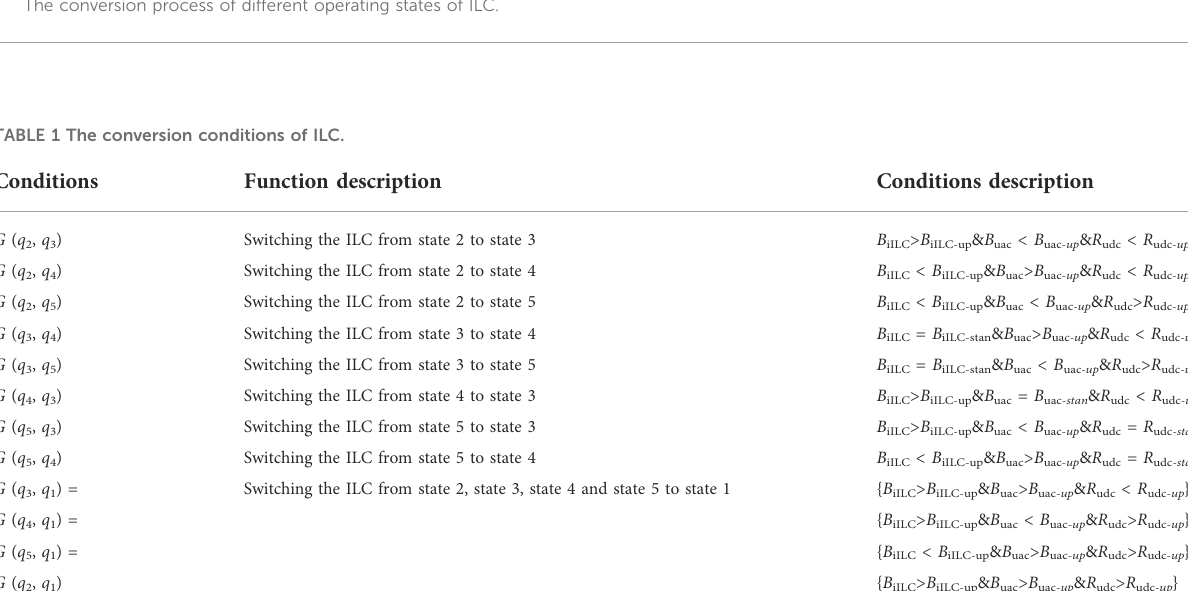
FIGURE 9 The conversion process of different operating states of ILC.